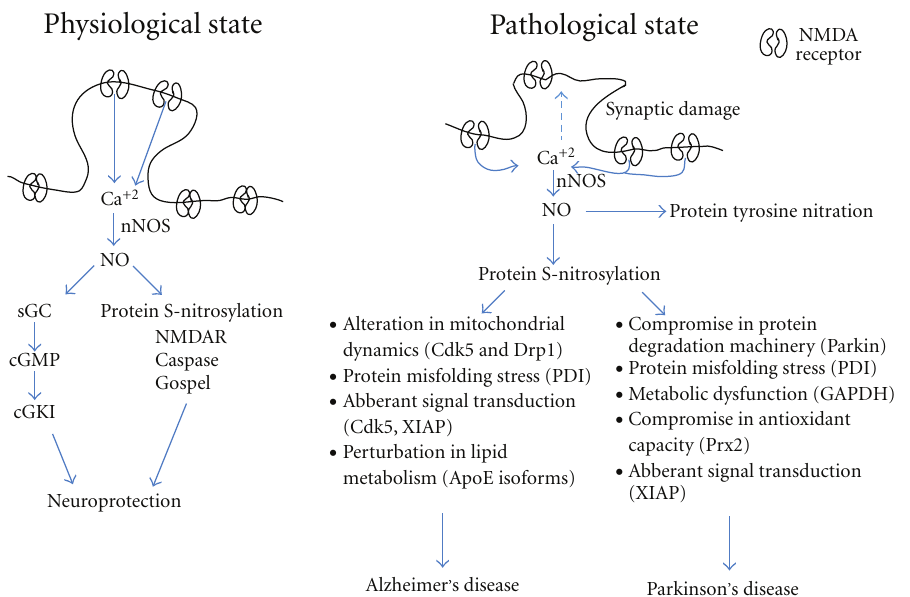
Figure 2: Nitric oxide signaling in neuroprotection and neurodegeneration. Synaptic activity results in NMDAR channel openings, allowing Ca 2+ entry that can activate nNOS to generate NO in neurons. Under physiological conditions, low levels of NO are produced in neurons by synaptic activity to activate neuroprotective signaling pathways involving cGMP-CGKI or S-nitrosylation of several critical proteins (NMDARs, Gospel, etc.). Under pathological conditions, excessive Ca 2+ enters primarily through extrasynaptic NMDARs, generating large concentrations of NO. The nitrosative stress thus generated contributes to synaptic damage and neuronal loss, in part by fostering aberrant protein S-nitrosylation. Various cellular processes, including mitochondrial dynamics, protein folding, lipid metabolism, protein degradation, and signal transduction pathways can be perturbed by aberrant protein S-nitrosylation. Compromise in one or several of these cell processes can contribute to neurodegeneration. It should be noted, however, that a number of additional pathways, not related to NO, that are triggered by synaptic activity can also contribute to neuroprotection, while a number of pathways a ff ected by extrasynaptic NMDAR activity appear to be involved in neuronal cell injury and death